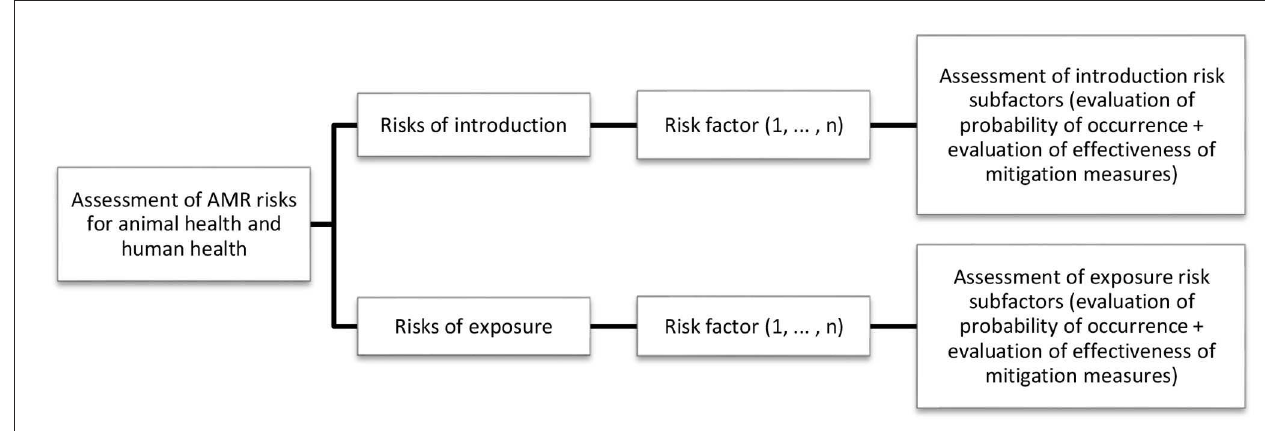
FIGURE3 General process for the qualitative assessment of AMR risks in animal and human health.